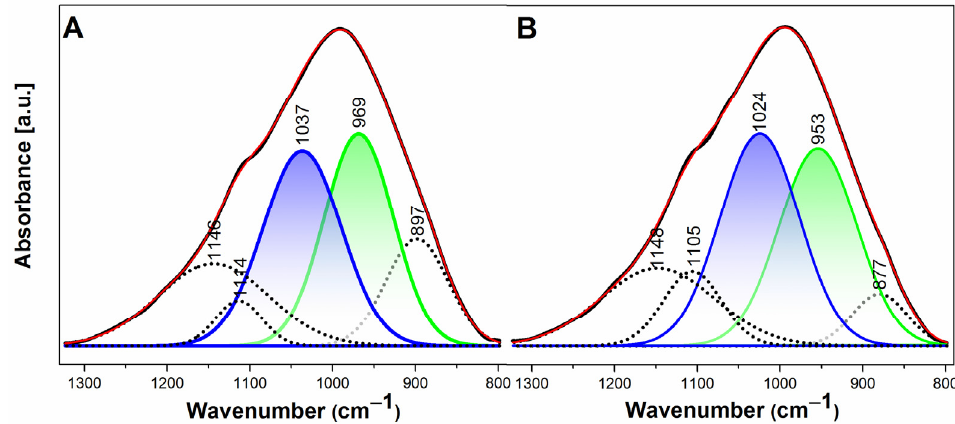
Figure 6. Deconvolution of ATR-FTIR spectra of selected geopolymer samples with curing time of 28 days and curing temperature of ( A ) 30; and ( B ) 90 °C.